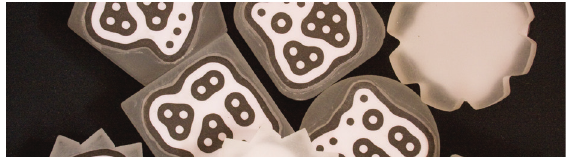
Fig. 6. Untitled* Objects/Generators (cid:1) Figure 6 : Untitled* Objects/Generators